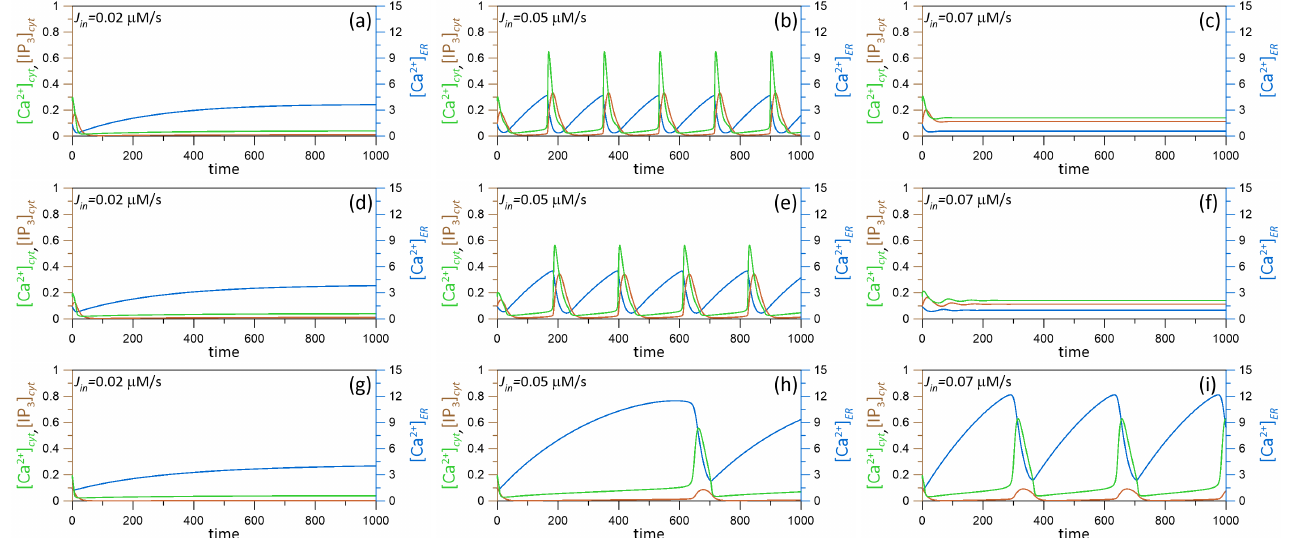
Figure 2. Time series of [ Ca 2 + ] cyt (green curves), [ Ca 2 + ] ER (blue curves), and [ IP 3 ] cyt (brown curves) obtained for three values of the calcium flow from the extracellular space into the cytosol of the astrocyte: ( a ) J in = 0.02 µ M/s; ( b ) J in = 0.05 µ M/s; and ( c ) J in = 0.07 µ M/s. For ( a – c ) the parameters are v M 2 = 15 µ M/s, v M 3 = 40 s − 1 , v p = 0.05 µ M/s. For ( d – f ) the parameters are v M 2 = 15 µ M/s, v M 3 = 20 s − 1 , v p = 0.05 µ M/s. For ( g – i ) the parameters are v M 2 = 15 µ M/s, v M 3 = 20 s − 1 , = 0.1 µ M, [ Ca 2 + ] 0 = 1.5 µ M, [ IP ] 0 = 0.1 µ v p = 0.01 µ M/s. Initial conditions: [ Ca 2 + ] 0 3 cyt cyt ER